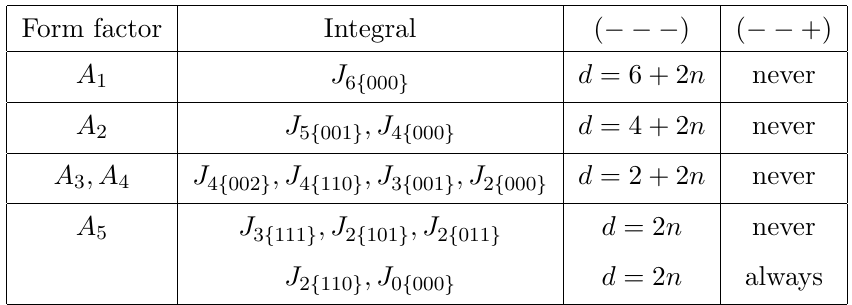
T (cid:22) T (cid:22) i . 1 (cid:23) 1 2 (cid:23) 2 3 (cid:23) 3